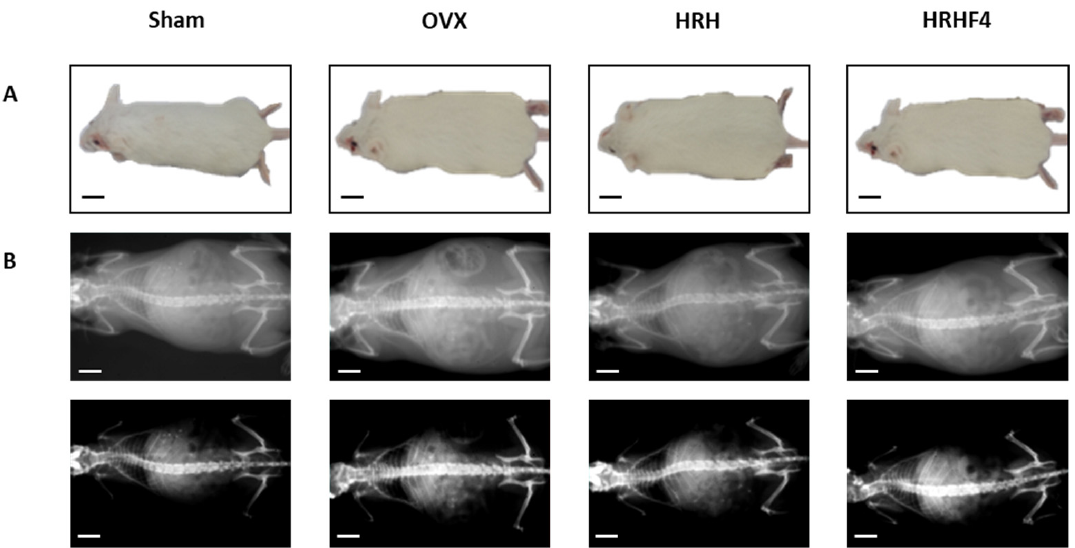
Figure 3. Representative images of each mouse group at the end of animal testing. ( A ) Whole body images of each mouse group. ( B ) whole body DEXA images of each mouse group. OVX, bilateral ovariectomy; HRH, Hexane-soluble fraction from ethanol extract of H. rhamnoides fruits; HRHF4, Hexane-soluble fraction number 4 from ethanol extract of H. rhamnoides fruits; DEXA, dual-energy X-ray absorptionmetry. Scale bar, 20 mm.